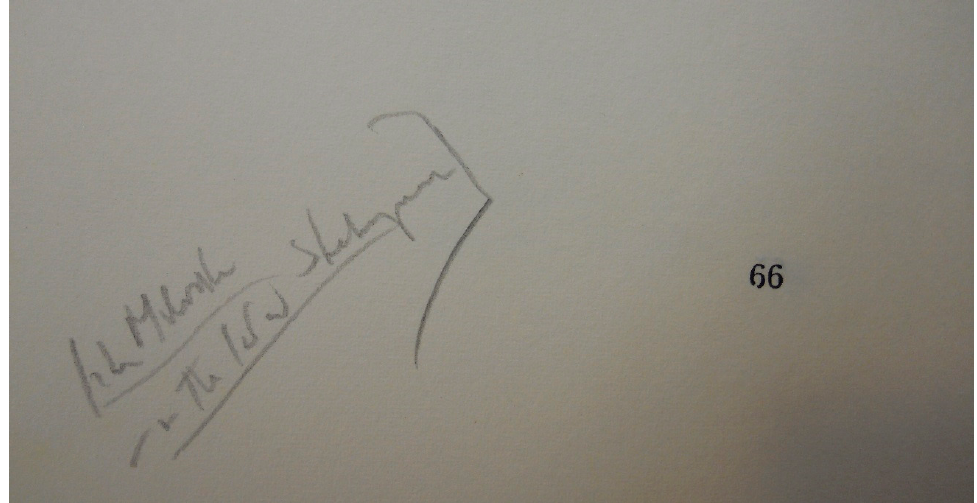
Figure 4. Page 66 of “Manuscript. Written on ‘Ace of Pentacles’ by John Wieners”, box 24, folder 1147, CORC.